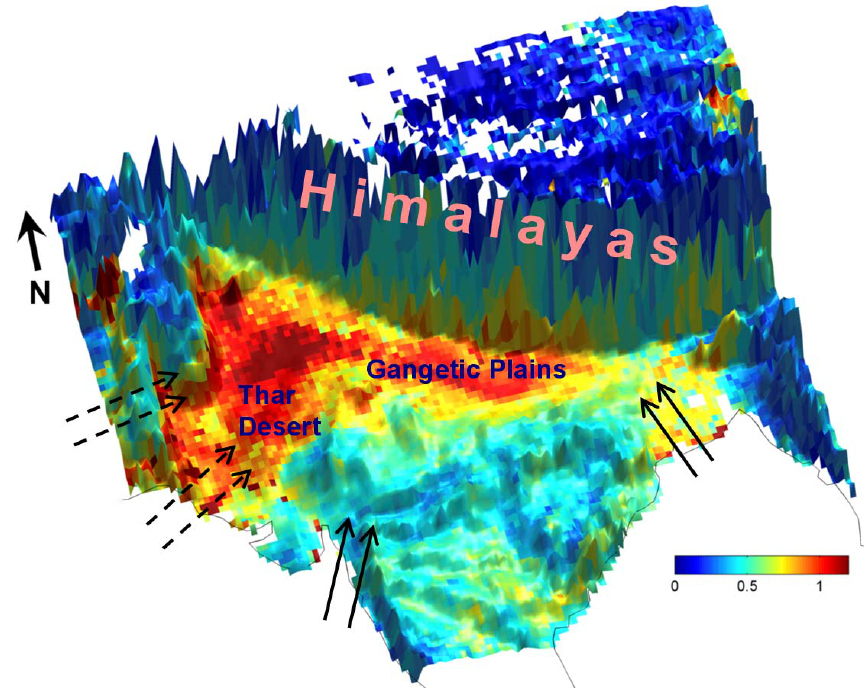
Figure 2 Fig. 2. Climatological mean of Aerosol Optical Depth during pre-monsoon season overlaid onto the surface topography (from Gautam et al., 2009b). Passage of dust transport is clearly visible from the western desert/arid regions into the alluvium of the IGP. Dashed arrows indicate pre-monsoon westerlies and black arrows indicate the passage of moisture transport from Arabian Sea/Indian Ocean into southern India and from Bay of Bengal into the eastern parts of the subcontinent during monsoon season.